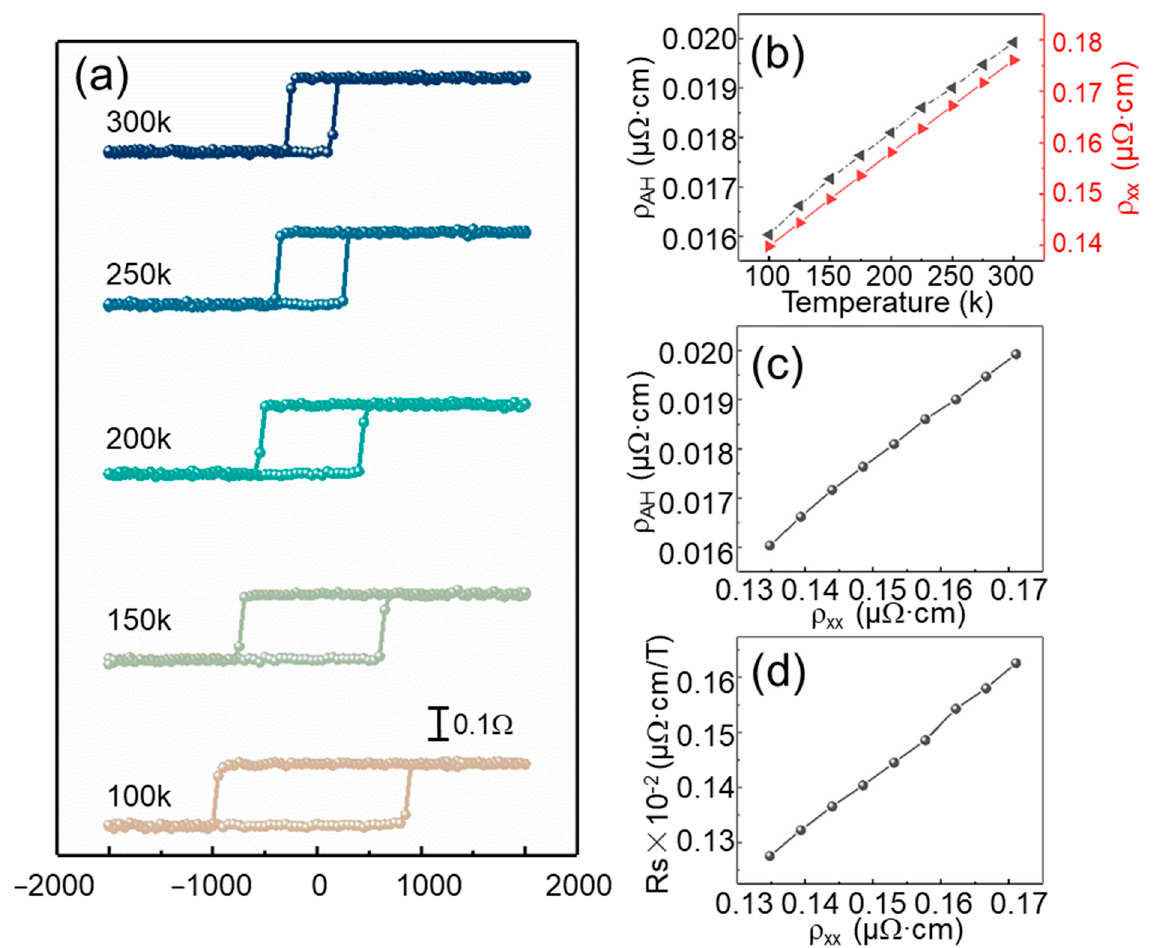
Figure 4. ( a ) Temperature-dependent hysteresis loop ranging from 100 K to 300 K. ( b ) The temperature dependence of ρ xx and ρ AH . ( c ) ρ AH − ρ xx curves of the heterostructure. ( d ) The relationship curve with R s and ρ x x . The red line is the fitting curve.